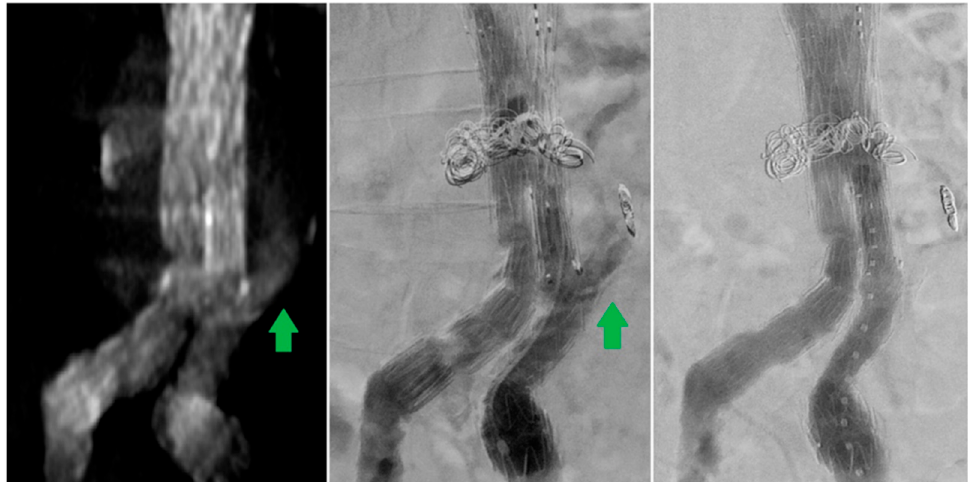
Figure 5. Patient 16 with a fenestrated endograft previously treated for a type II endoleak from the inferior mesenteric artery with coils. The standard computed tomography angiography showed a persistent endoleak with unknown origin. (not shown) The dynamic computed tomography angiography showed the origin from the left iliac branch (green arrow).